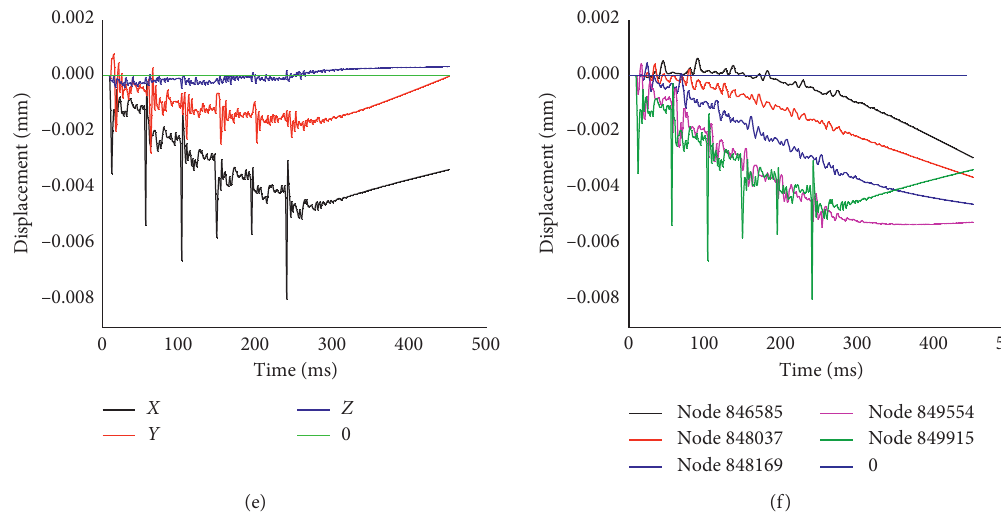
Figure 11: The displacement versus time response curves for the supporting pile: (a) node no. 846585, (b) node no. 848037, (c) node no. 848169, (d) node no. 849554, (e) node no. 849915, and (f) the X direction.